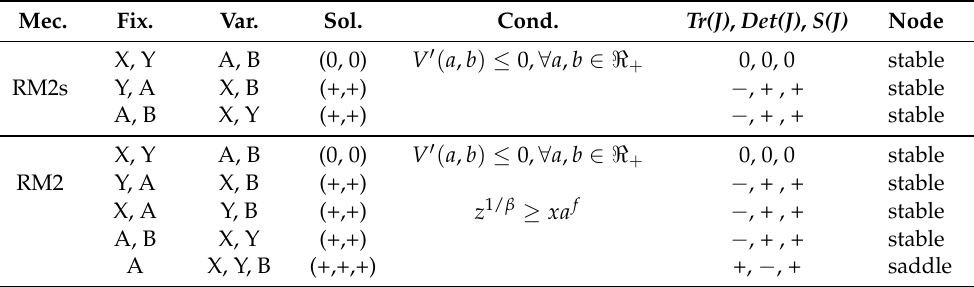
Table 4. Table of stability behaviours around real positive critical points. The columns are in the following order: the reaction mechanism (Mec.), the fixed variables (Fix.), the variables of the ODEs (Var.), the solutions of the ODEs (Sol.), the conditions for the solutions (Cond.), the signs for the trace Tr(J) , the determinant Det(J) , and S ( J ) = Tr ( J ) 2 − 4 Det ( J ) of the ODEs’ Jacobian, and the nature of the critical